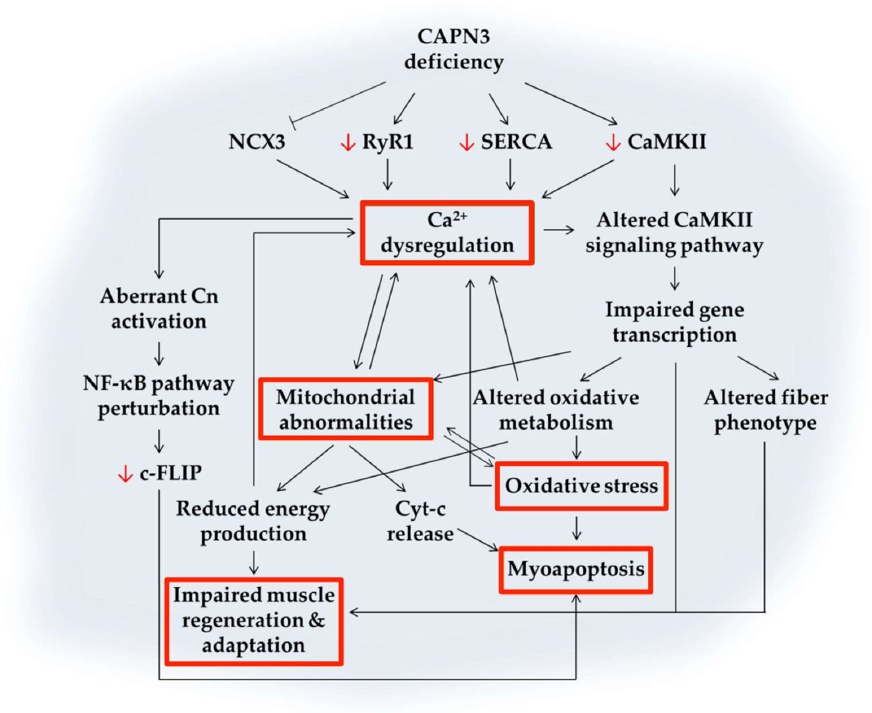
Figure 5. Schematic representation of putative Ca 2 + -mediated pathogenic mechanisms triggered by CAPN3 deficiency. CAPN3 deficiency results in reduced levels of RyR1, SERCA, and CaMKII. In addition, NCX3 activity may also be reduced. The decreased function of major Ca 2 + -handling proteins results in Ca 2 + dysregulation and increased intracellular [Ca 2 + ]. Reduced CaMKII levels together with Ca 2 + dysregulation compromise CaMK downstream signaling pathways, which may lead to impaired gene transcription, mitochondrial abnormalities, oxidative stress, altered fiber phenotype, and impaired muscle regeneration. Mitochondrial abnormalities aggravate Ca 2 + dysregulation and oxidative damage. They may also impact energy production and promote apoptosis through Cyt-c release and activation of caspases. Among these mechanisms, multiple feedback loops lead to altered Ca 2 + levels and may result in myoapoptosis and muscle waste. Black arrows or blunt ends indicate enhancing or inhibitory e ff ects, respectively. Red arrows indicate decreased protein expression. Text in red boxes represent several pathological features of CAPN3, as described in Figure